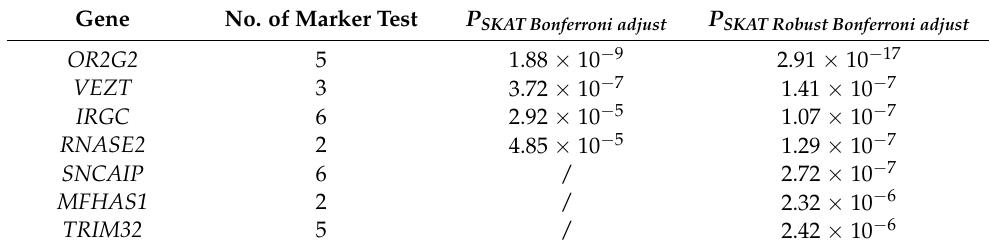
Table 2. Gene-based association analysis results of habitual coffee consumption. Gene